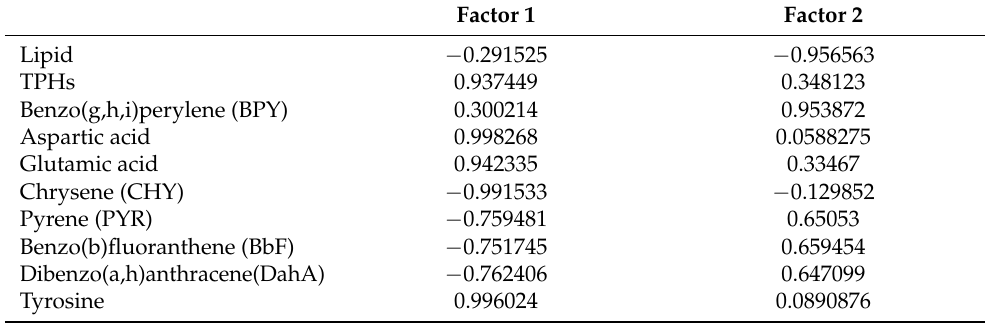
Table 12. Factor Analysis.